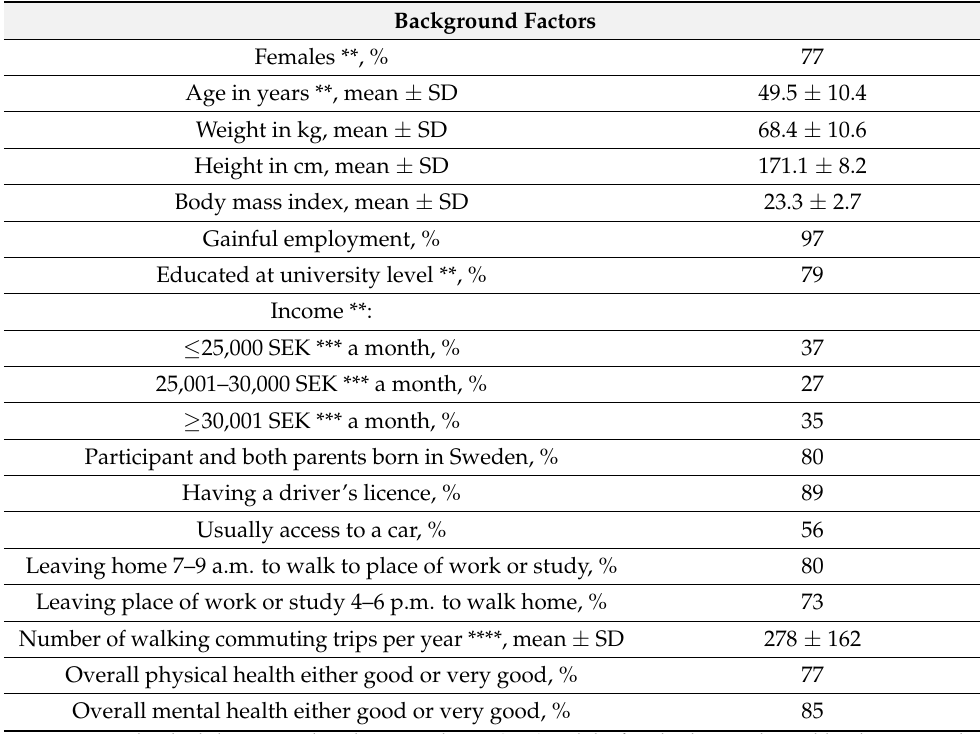
Table 1. Descriptive characteristics of participants ( n = 282–294)